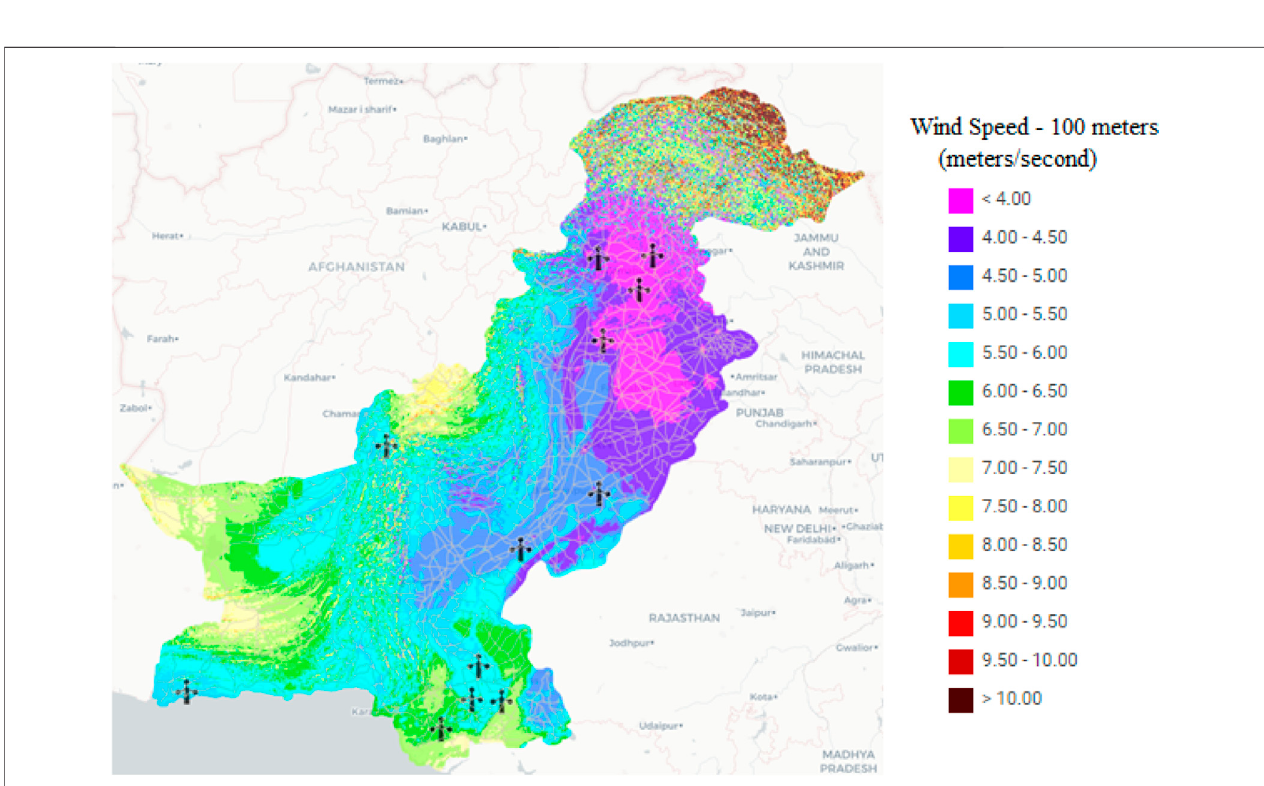
FIGURE 3 | Wind map of Pakistan (NREL GIS,